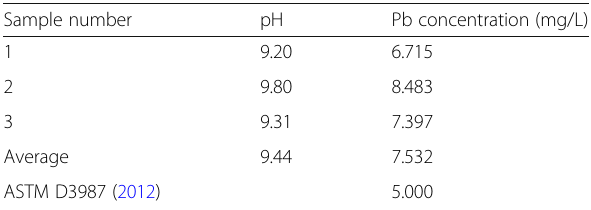
Table 2 Measured pH value and Pb concentration of the sludge